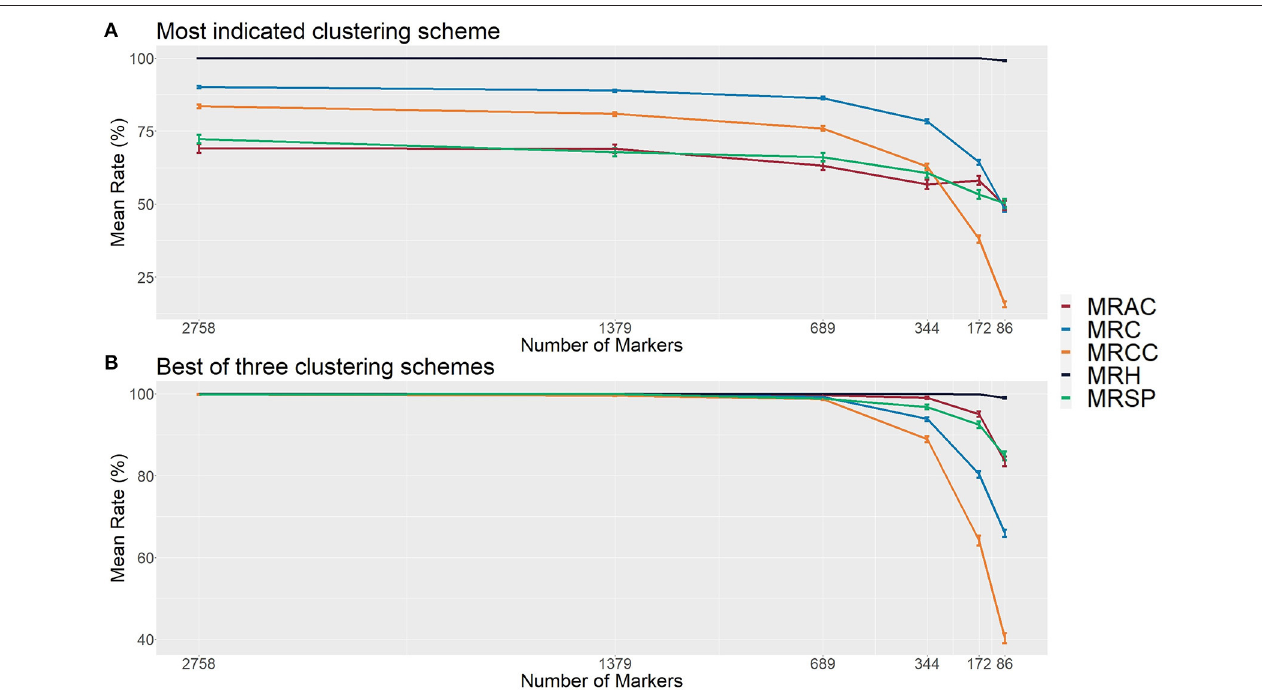
FIGURE 5 | Evaluation metrics of the proposed methodology considering six different set sizes of makers in simulated populations (1,000 populations for each set). (A) The most indicated clustering scheme, and (B) the best out of the first three most indicated schemes found with the 27 employed clustering indexes. The indicated rates are the mean rate of hybrids correctly identified (MRH), the mean rate of contaminants correctly identified (MRC), the mean rate of apomictic clones correctly identified (MRAC), the mean rate of self-fertilized progeny correctly identified (MRSP), and the mean rate of cross-contaminants (HSs/FCs) correctly identified